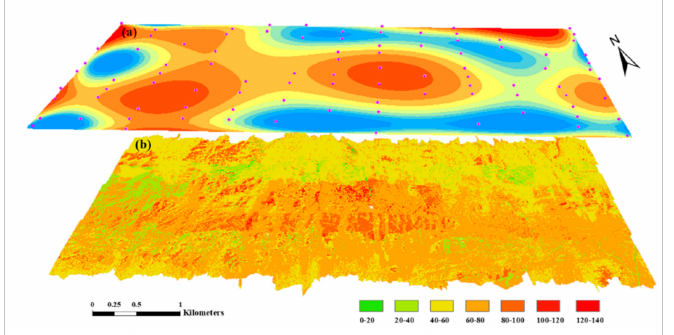
Figure 13. Cu content distribution map in the study area: ( a ) kriging interpolation; ( b ) hyperspectral